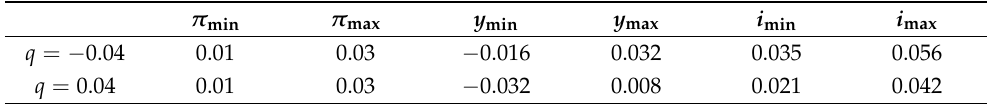
Table 2. Minimum and maximum viable values of inflation, output gap and interest rate (all in level terms) for v = 0.